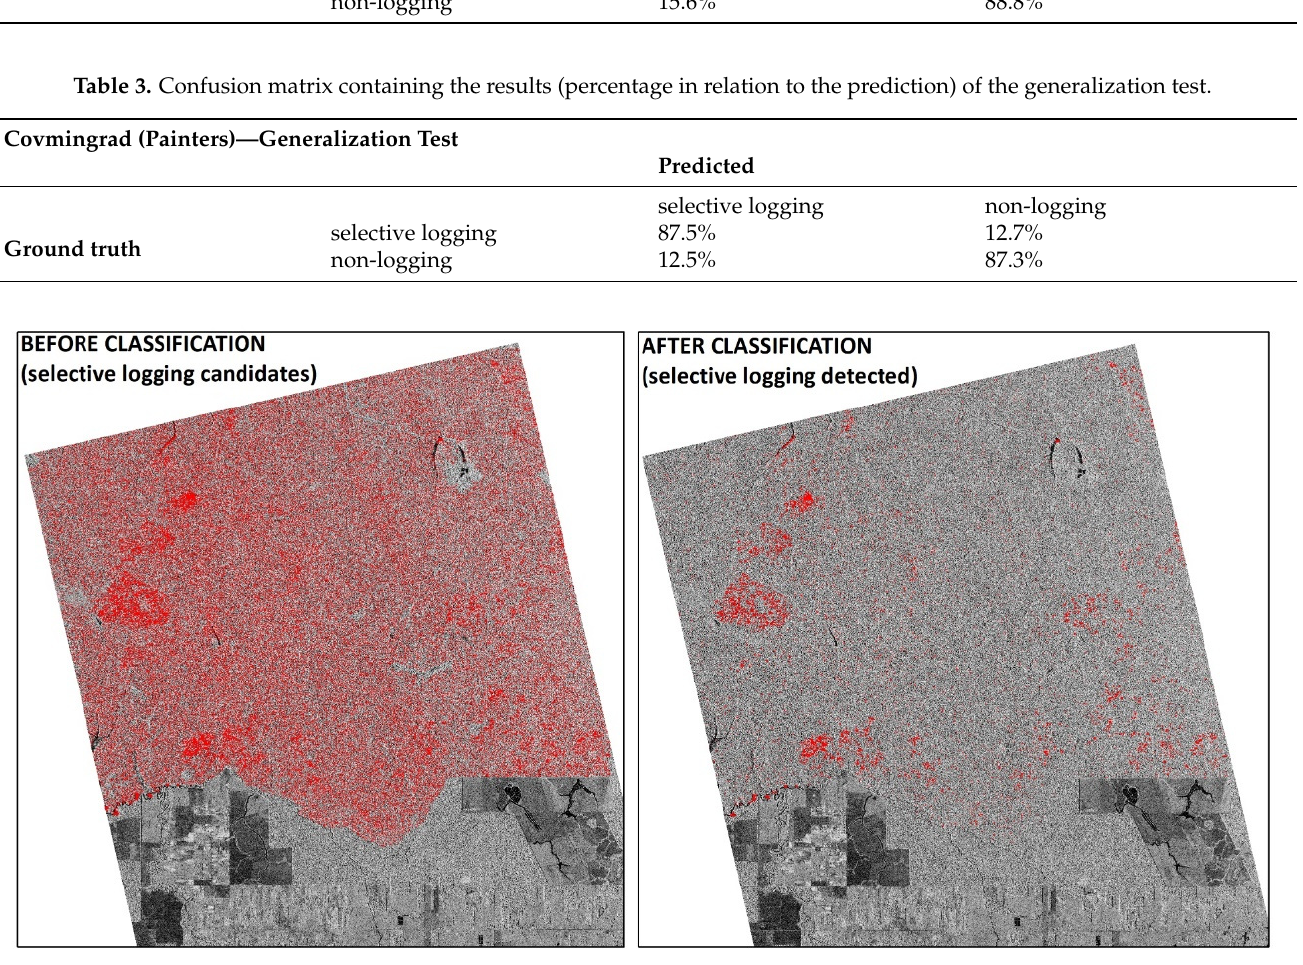
Figure 5. Selective logging candidates before and after classification.